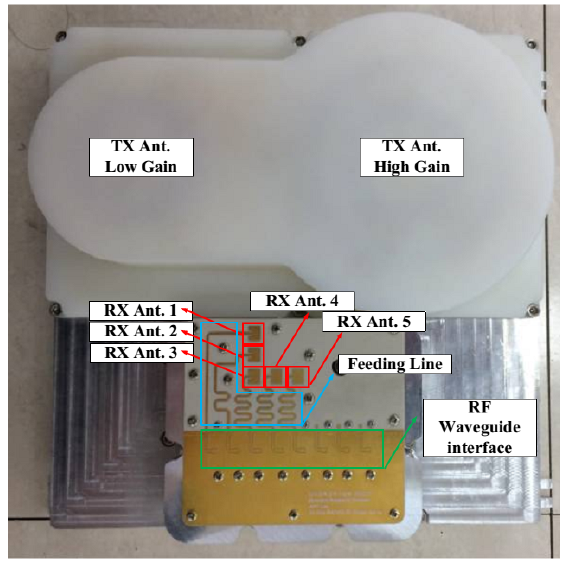
Figure 3. Transmitting lens antenna and receiving L-shaped antenna. TX: transmission, RF: radio